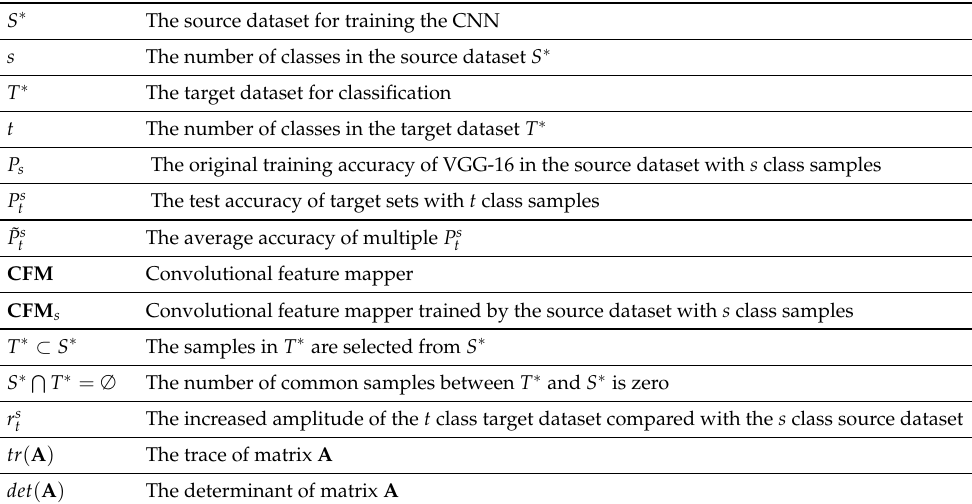
Table 1. Important notations and variables used in this